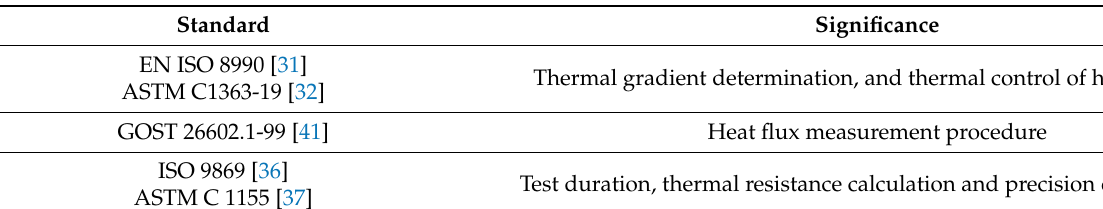
Table 1. List of standards and their significance for the study.